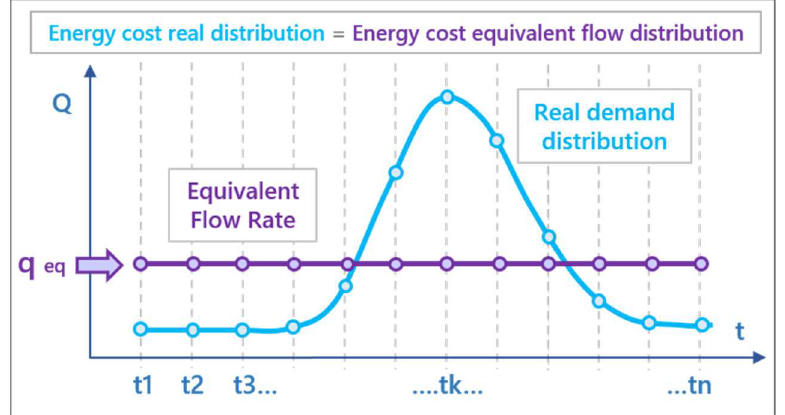
Figure 4. Equivalent Flow Rate definition.